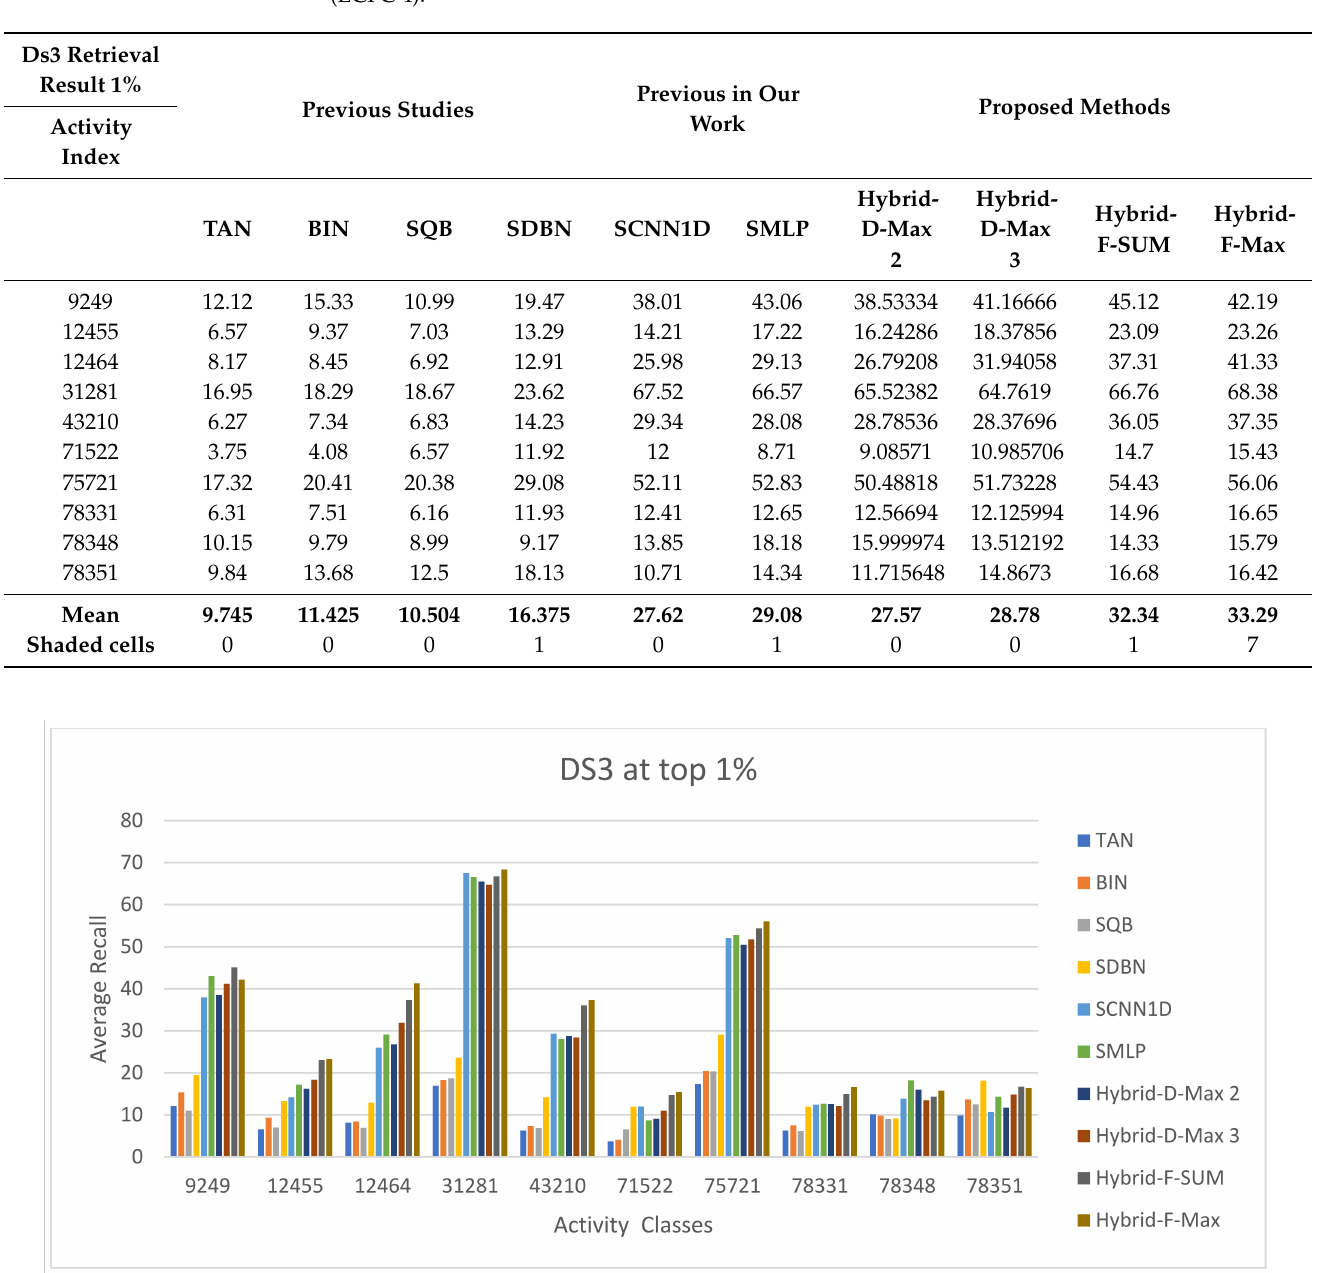
Table 9. Top 1% retrieval recall for MDDR-DS3 (structurally heterogeneous) dataset for descriptor (ECFC 4).